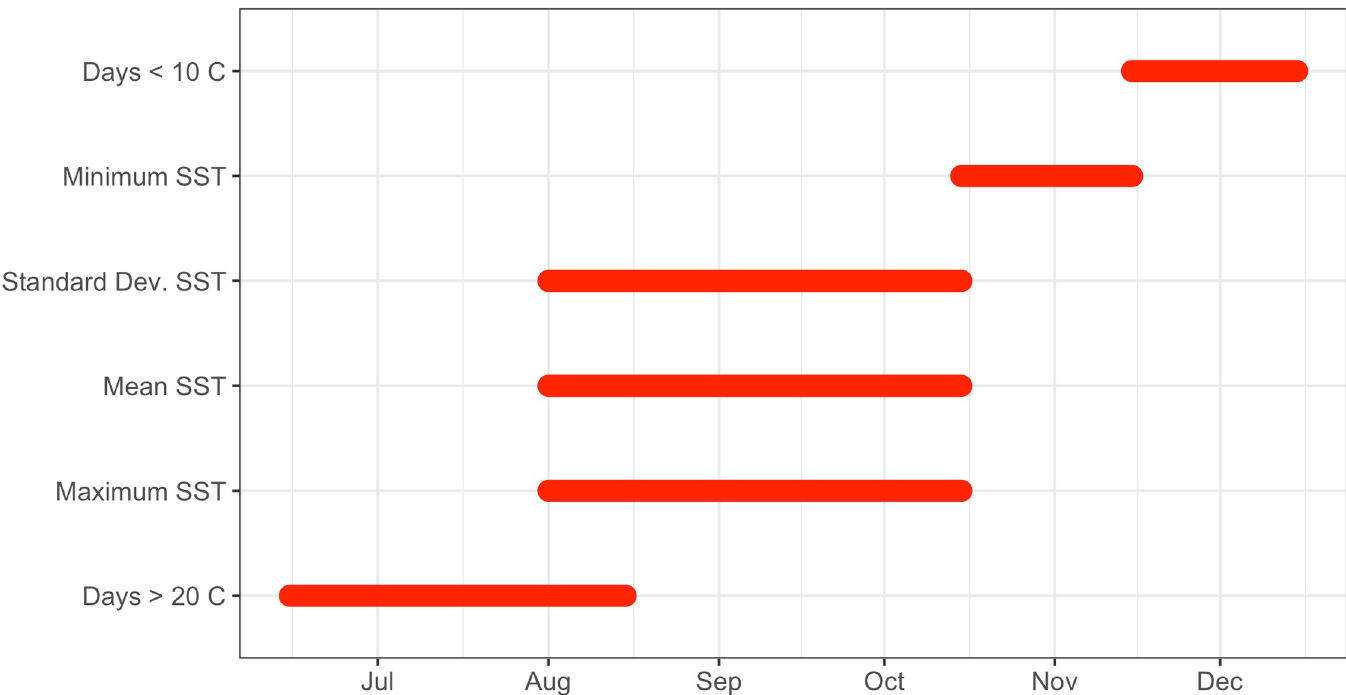
Fig 2. Optimal climate time windows for selected variables. As identified by the climwin package [35] for each aggregate SST statistic, including: mean, maximum, minimum, and standard deviation of the daily mean SSTs, number of days with daily SST below 10˚C, and number of days with daily SST above 20˚C.